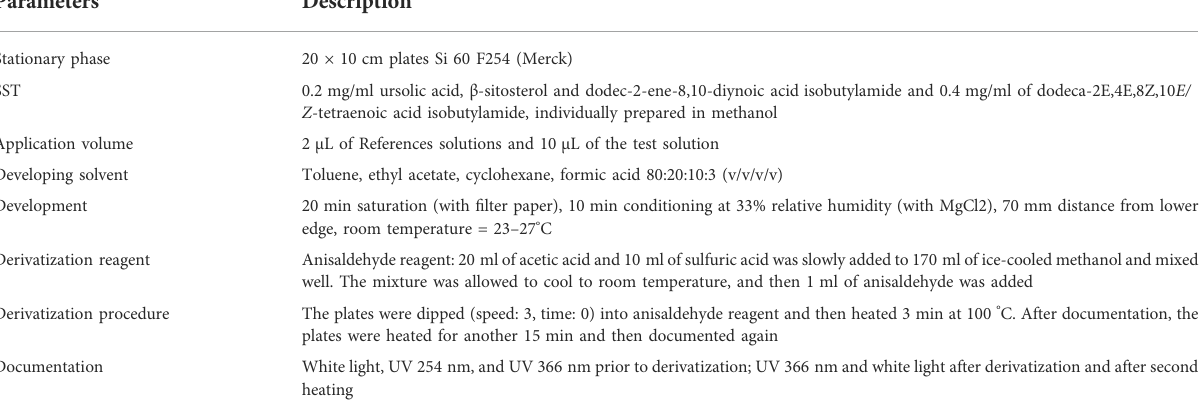
TABLE 3 HPTLC parameters for identi fi cation of cone fl ower roots and aerial parts, alkylamides. Parameters